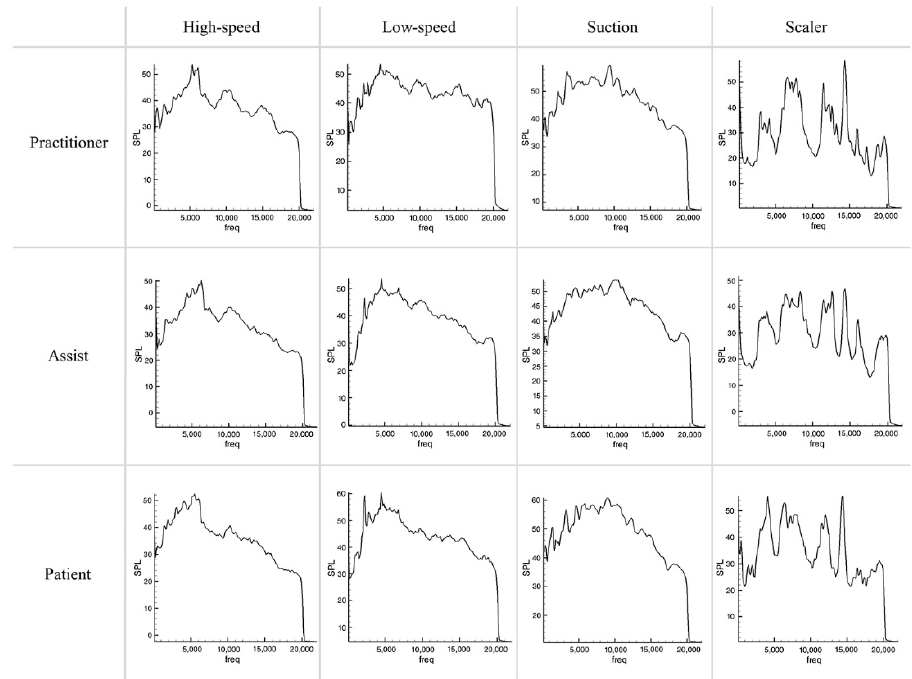
Figure 3. Sound pressure level graphs of dental noise from high − speed, low − speed, suction, and scaler during tooth preparation.